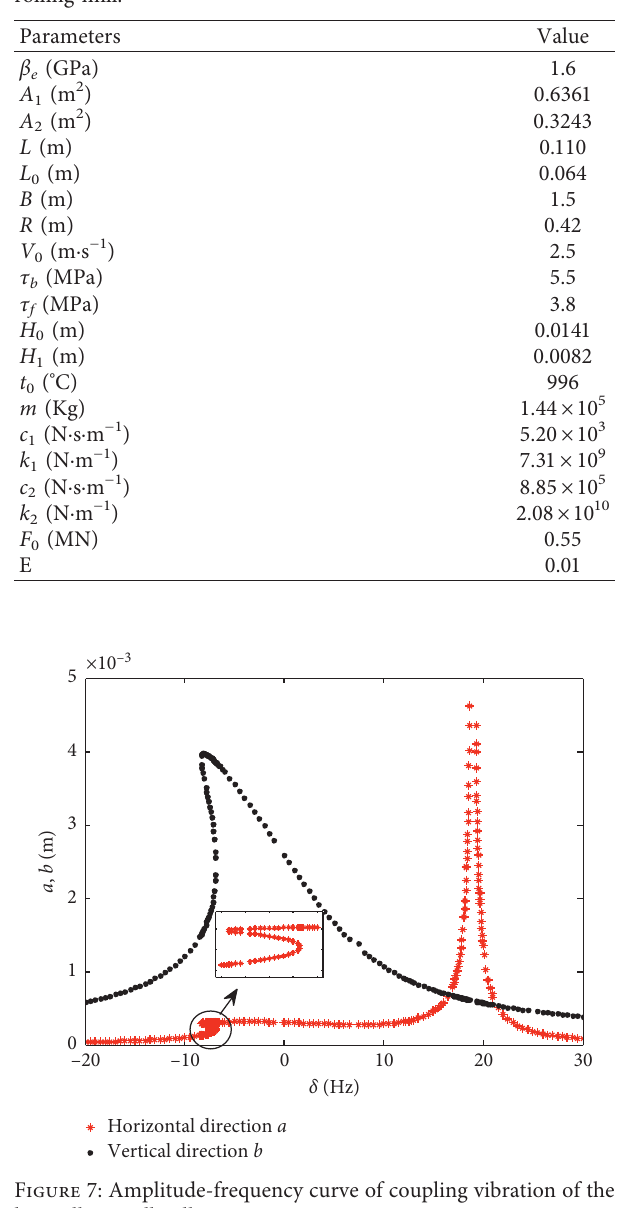
Table 1: Structural and technological parameters of the 1780 hot rolling mill.